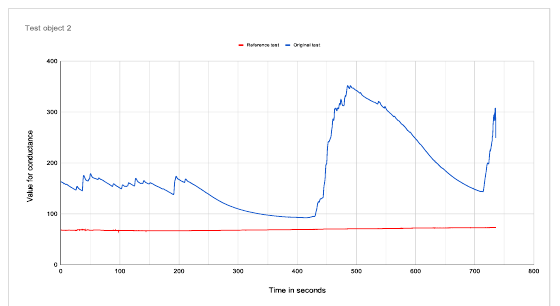
Figure 7: Plot of conductance for test subject 2 Percentage change with electrodes in palm: 73,78% Percentage change with electrodes on arm: 13,48%